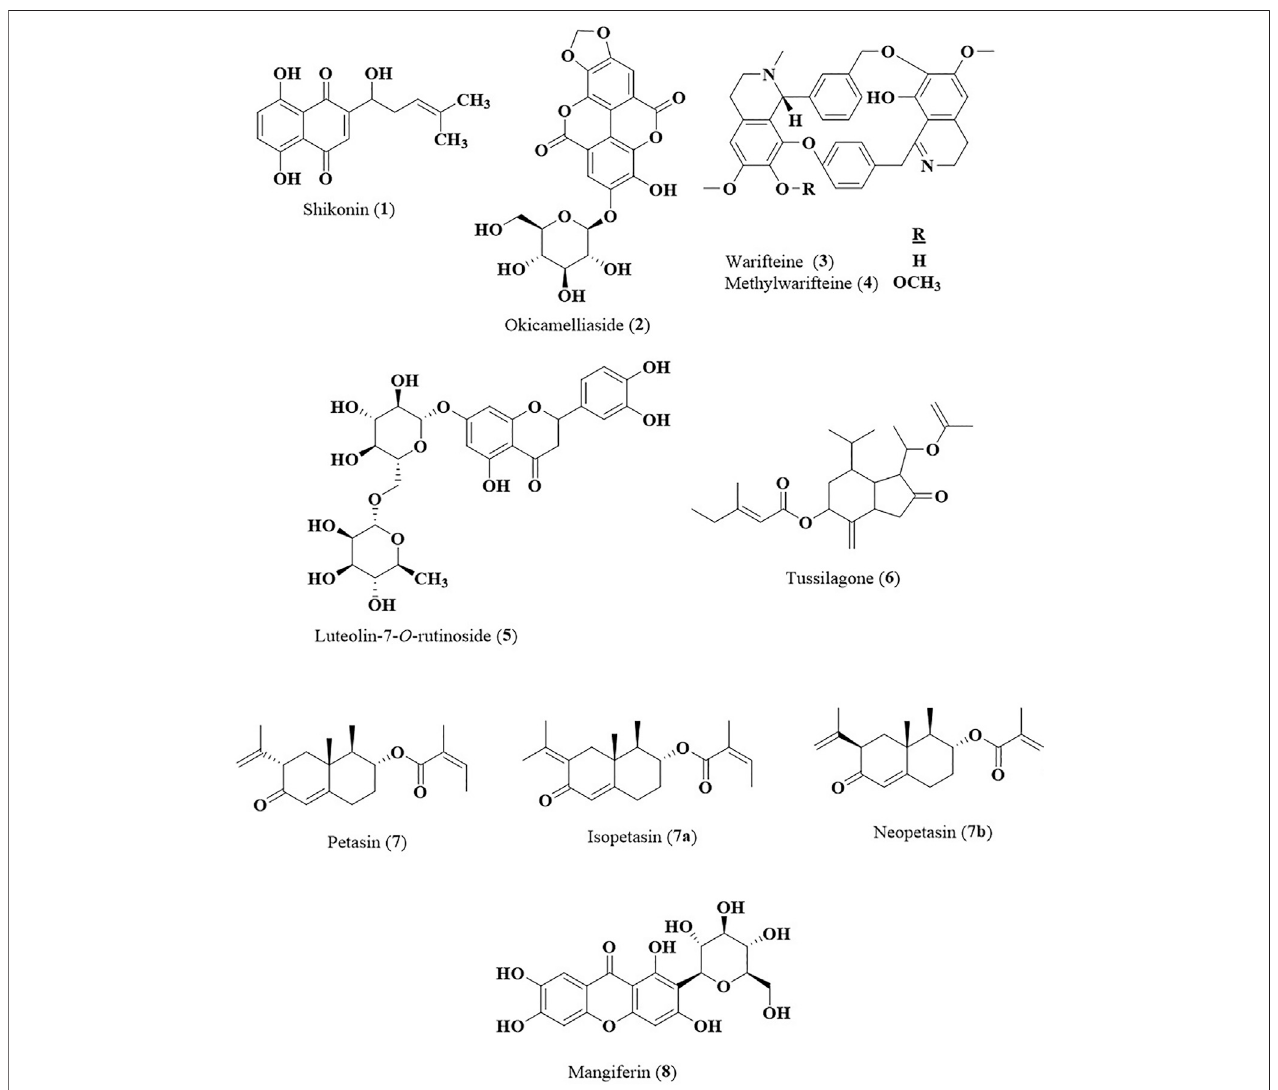
FIGURE 2 | Chemical structures of compounds with strong anti-allergic rhinitis